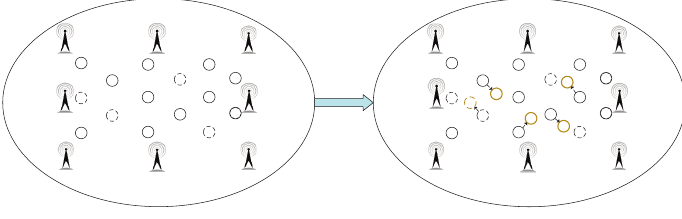
Figure 6. The Dynamic Changes to the Simulation Environment.